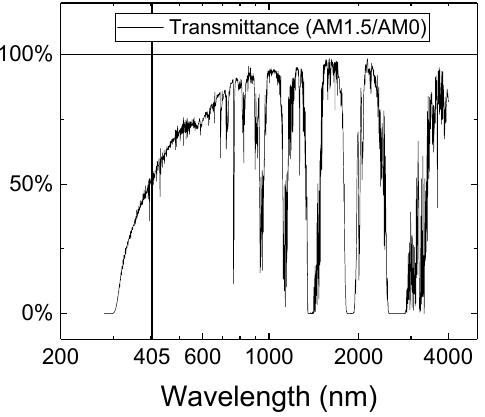
Figure 9. Air transmittance, computed as the ratio between the AM1.5 and the AM0 spectra.